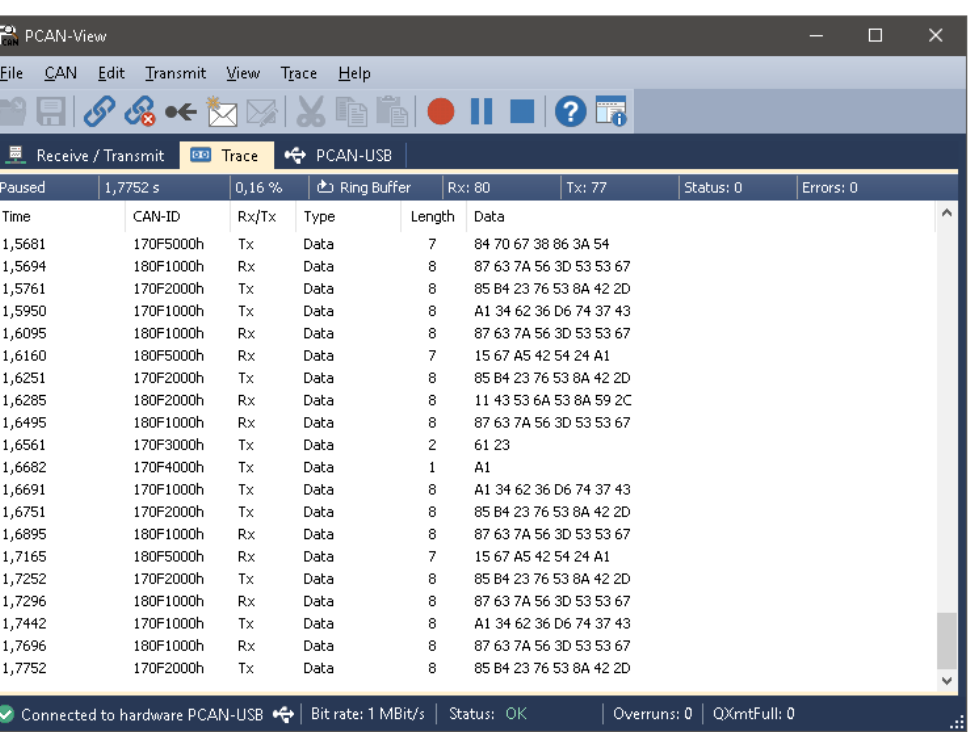
Figure 11. PCAN Software Window—Recorded data.